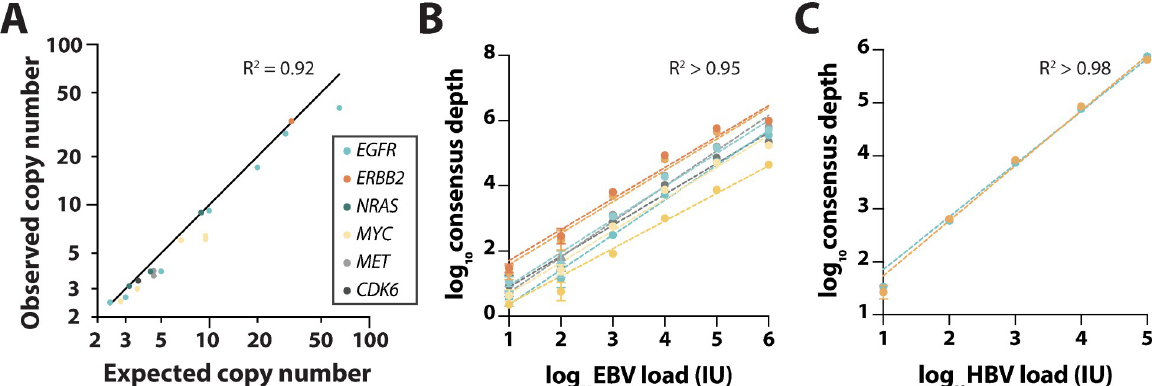
Fig 3. Validation of LiquidHALLMARK read count-based biomarkers. (A) Positive concordance of observed and expected copy numbers for amplification in six genes using HD786 reference standard and contrived admixtures of fragmented cell-line DNA. Observed consensus depth relative to (B) Epstein-Barr virus (EBV) and (C) hepatitis B virus (HBV) viral loads in plasma. Data is represented as mean ± SD from four replicate experiments. Each color represents a unique virus-specific amplicon. Correlation between consensus depth and viral load is based on linear